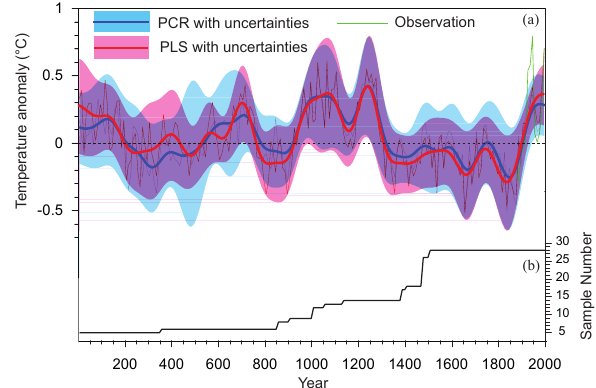
Fig. 2. (a) Ensemble temperature reconstructions based on PLS (red lines) and PCR (blue lines) methods at decadal (thin lines) and cen- tennial timescales (solid lines; smoothed by a 5-point FFT filter), along with the 95% confidence level (shading). The reference value is the mean temperature from 1851 to 1950. The green line indicates the observed average air temperature. (b) Numbers of samples used.